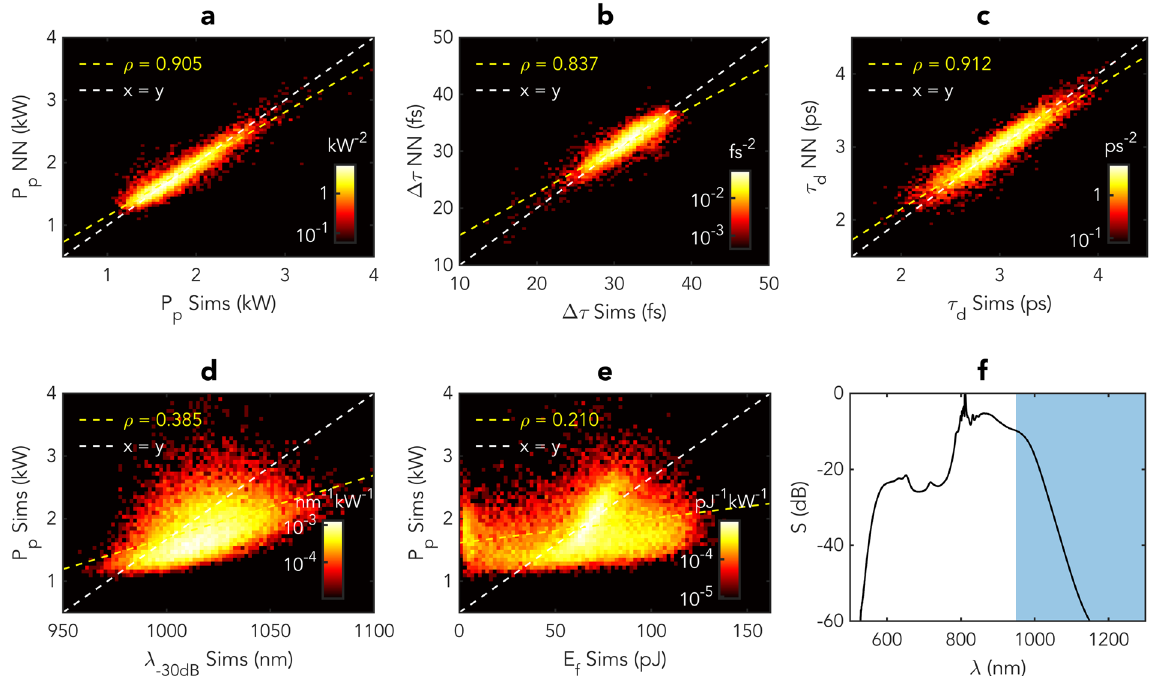
Figure 3. Results showing prediction of the rogue soliton characteristics by the neural network for an ensemble of 10,000 SC ensemble generated with identical input pulses (except for the noise seed). ( a ) compares the predicted maximum intensity of the most red-shifted soliton with the exact value simulated time-domain profiles. ( b ) compares the predicted duration Δ τ of the solitons with the exact value from the simulations. ( c ) compares the predicted delay τ d of the solitons with the exact value from the simulations. ( d ) plots the relation between the SC spectral bandwidth and peak power of the most red-shifted soliton. ( e ) plots the relation between the SC energy beyond 950 nm corresponding to the shaded area in ( f )) and peak power of the most red-shifted soliton. ( f ) shows the average spectrum of the data ensemble. For all sub-figures, the logarithmic histograms show the normalized density of points grouped into bins of constant area. The dashed white line in each case marks the 1-to-1 correspondence and the yellow dashed line is a linear fit to the predictions along with the Pearson correlation coefficient ρ